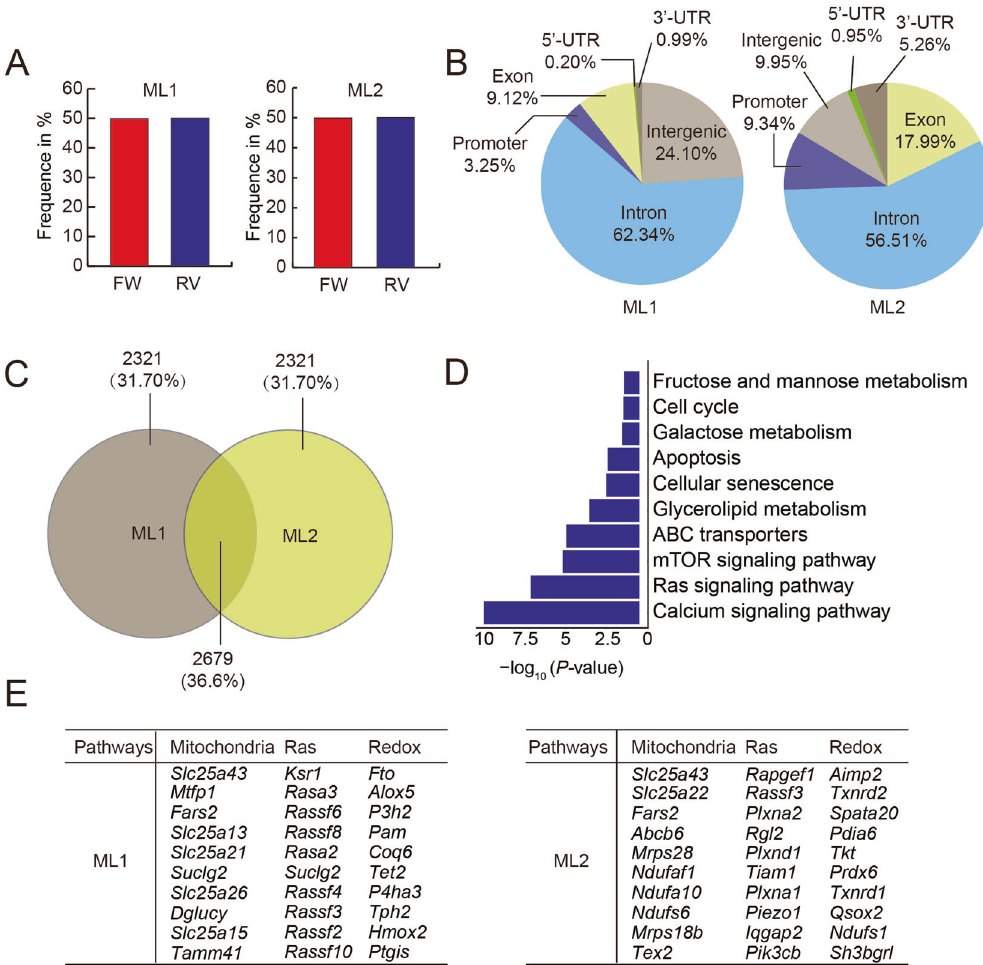
Fig. 2 Bioinformatics analysis of integrations in HaESCs. A Proportion of the insertional orientation (sense/antisense) after PB integration in mutant library 1 (ML1) and mutant library 2 (ML2). B Analysis of integration sites after H 2 O 2 selection over genomic regions: promoters (1 kb upstream of the transcription starting sites), intragenic regions and intergenic regions in ML1 and ML2. C Venn diagram illustrating the overlapping genes among the top 5000 genes in ML1 and ML2. D KEGG analysis of the overlapping genes of ML1 and ML2. E Lists of insertion genes from H 2 O 2 -resistant screening related to mitochondria, Ras signaling pathway and redox